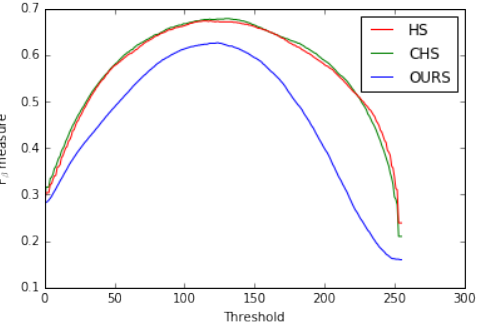
Figure 16. F β measure curves for HS [8], CHS [52] models and ours on the ECSSD dataset.